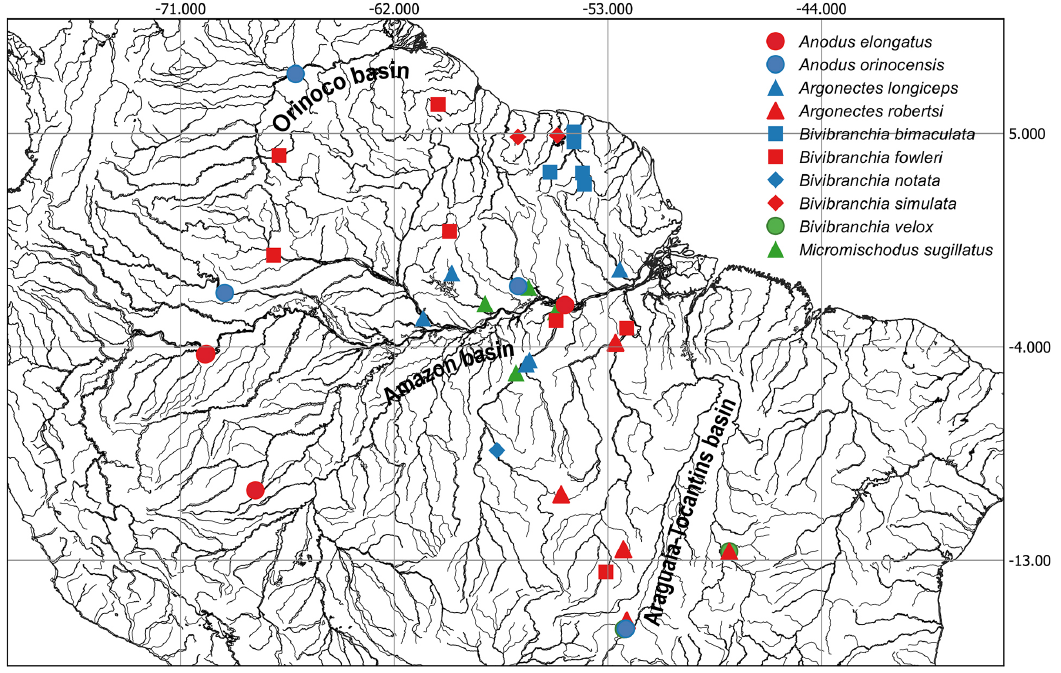
FIGURE 1 | Map of northern South America showing collection sites of Hemiodontidae specimens analysed in this study, per species.